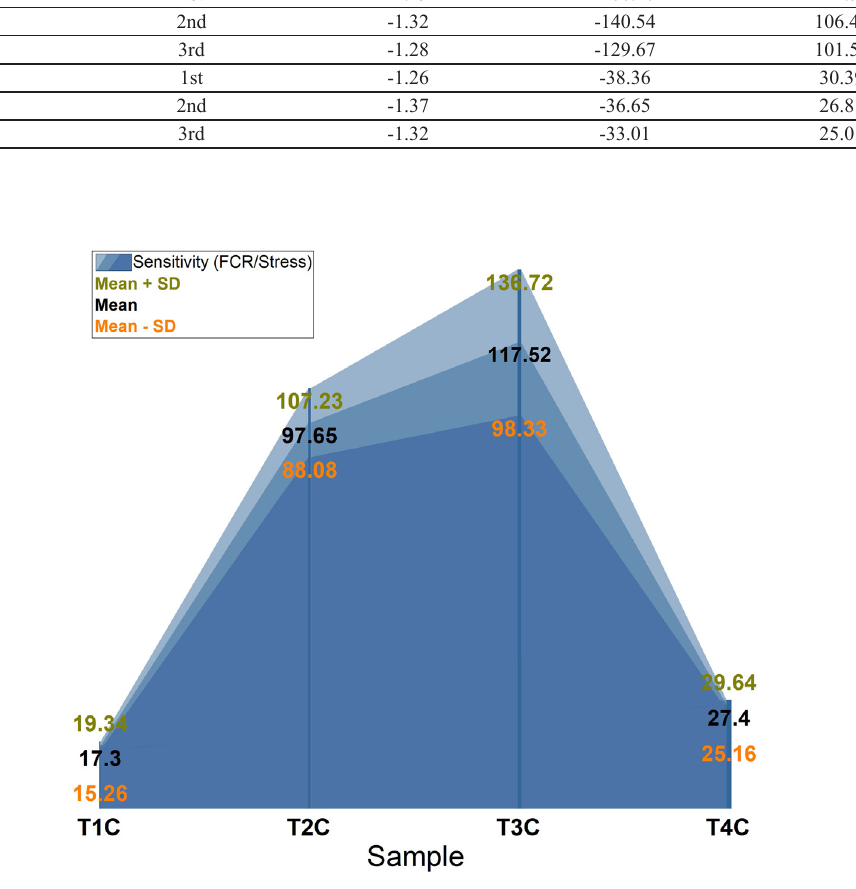
Figure 9. Mean sensitivity and standard deviations (SD) of